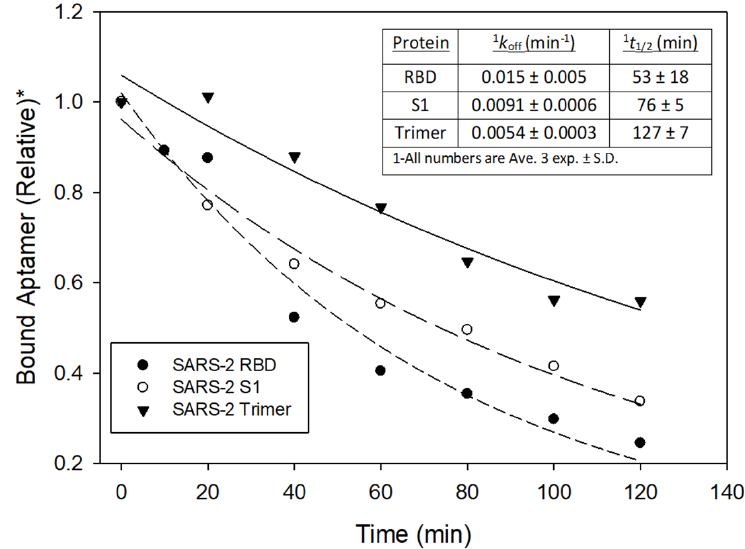
Figure 4. Example of an off-rate analysis of FANA-R8–9 from SARS-CoV-2 RBD, S1, and trimer proteins. Experiments to examine the dissociation of aptamer from various proteins were con- ducted as described in Materials and Methods. Data was fit to a curve for single parameter expo- nential decay to calculate off-rate ( k off ) and half-life (t 1/2 ). The experiment was repeated 3 times to yield k off and t 1/2 values shown in the insert table. The FANA-ST starting material bound very weakly in this assay with no significant level of bound material (using RBD) being measurable at the 20 min time point. *Values are relative to the value for bound material at time 0.